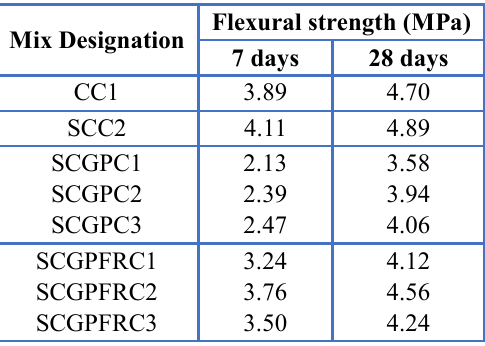
Flexural strength values for all mixes.